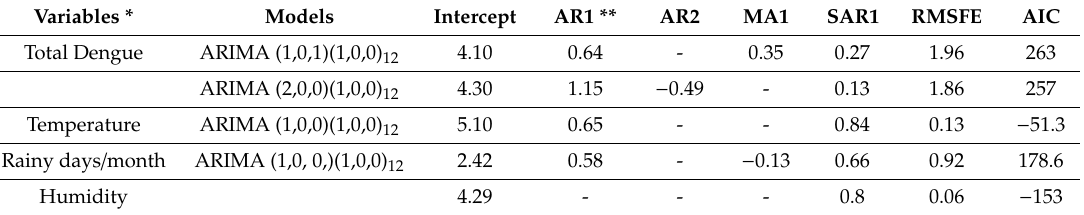
Figure 2. Monthly aggregated observations for hospitalized dengue cases from Zone-5 and weather parameters from 2005 to 2009 in Dhaka city.